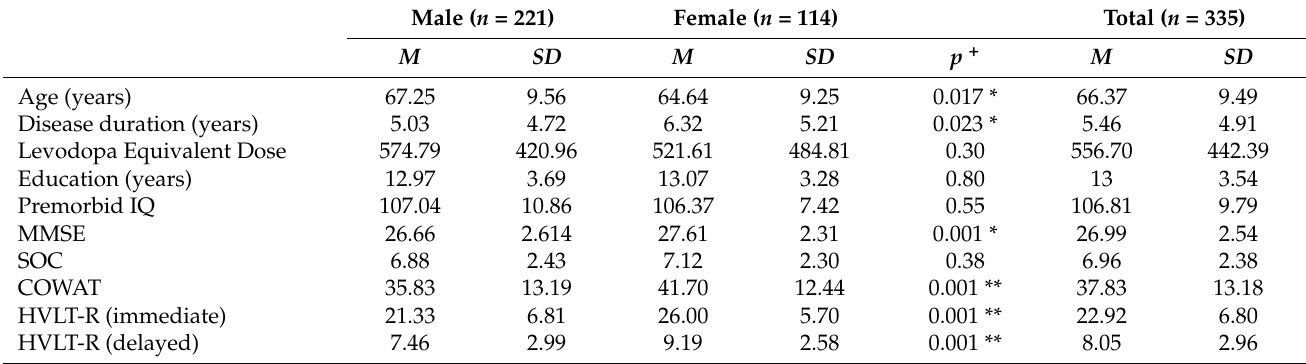
Table 1. Demographic characteristics and cognition scores, stratified by sex.